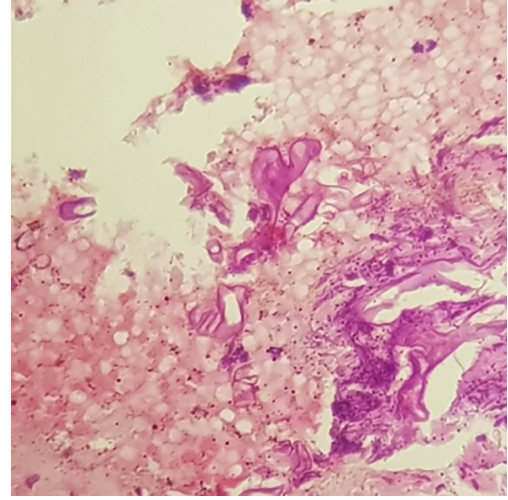
Figure 7b - B, Same region with autophages with viral inclusions in the cytoplasm of alveolar macrophages with hemorrhage. Hematoxylin and eosin, х400.